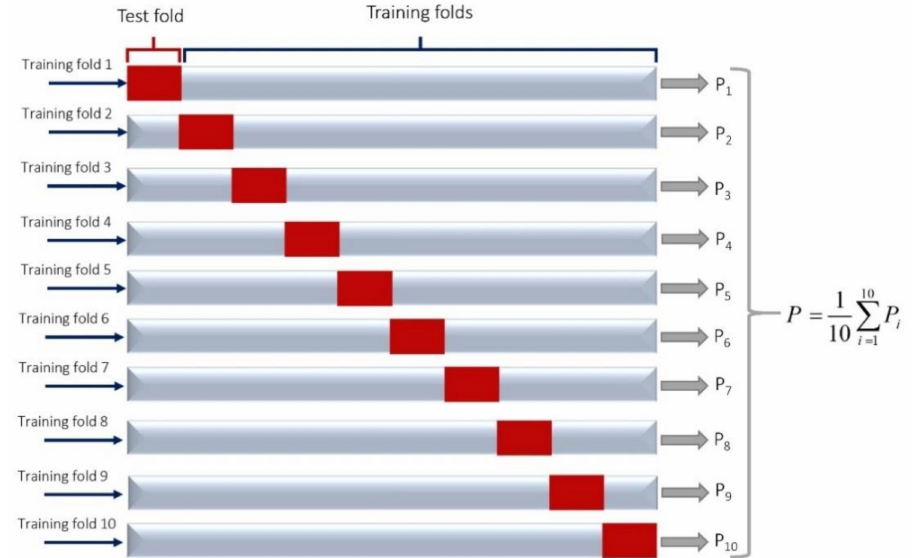
Figure 6. General structure of 10-fold cross-validation used in this